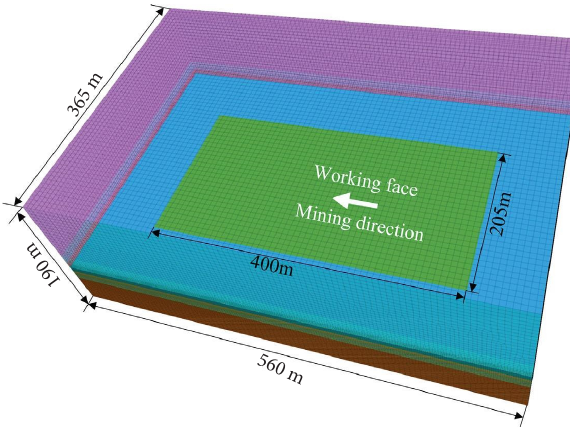
Figure 3: Tree-bit grid division of the Table 1: Physical and mechanical parameters of coal and rock.